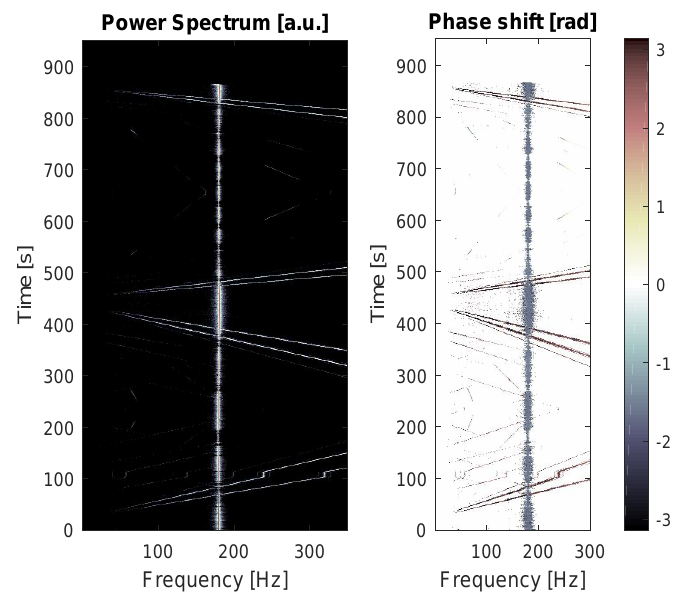
Figure 19. Scanning through the bulk mode of an Helmholtz